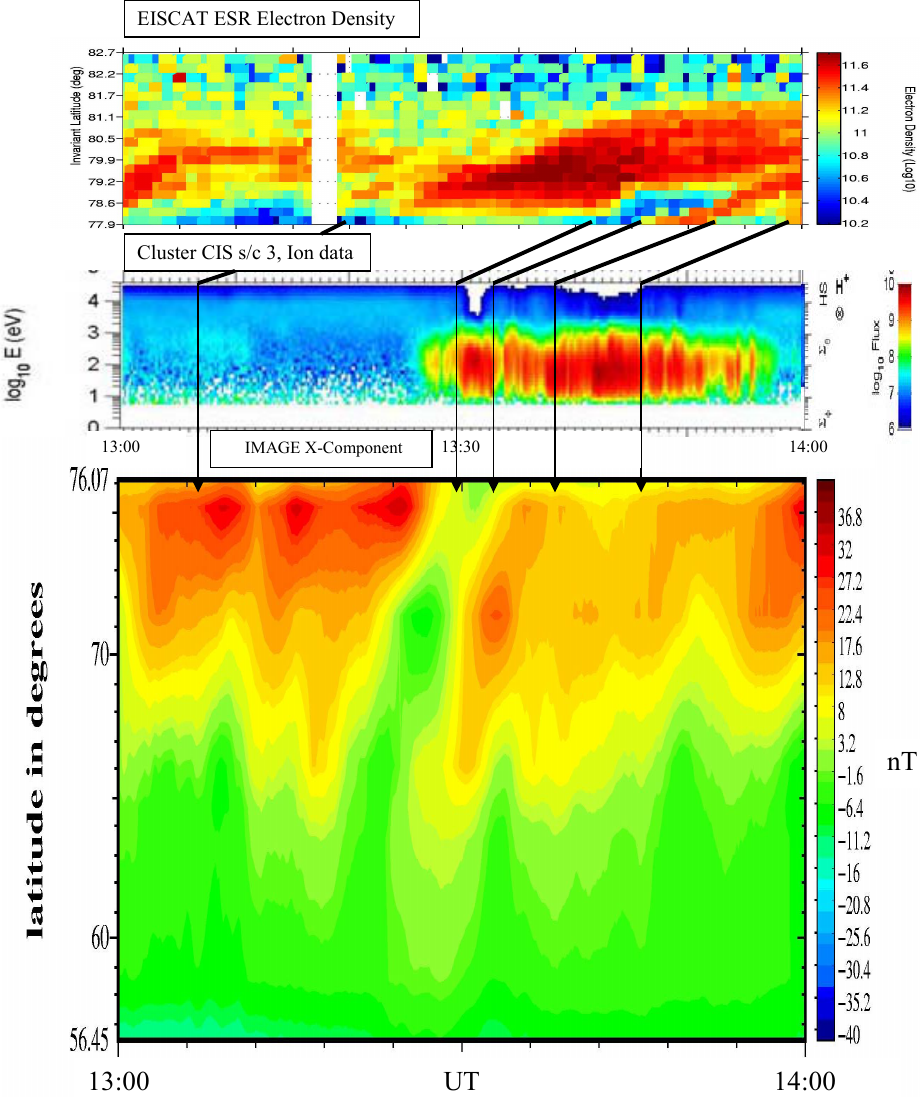
Fig. 14. Stacked plot of ESR electron density along the northward pointing radar beam (top panel, as in Fig. 13), total ion flux data from the CIS instrument on Cluster spacecraft3, and the magnetic X -component disturbance along the central meridian of the IMAGE magnetometer array, ranging from southern Finland to just southward of the latitude of the ESR measurement range along the poleward pointing beam. The thin arrows mark the relation between features in the CIS ion data with regions of eastward (red) and westward (green) current flow in the magnetometer data. Heavier bars illustrate the possible continuation of the poleward propagation of these features towards the southernmost latitude of the